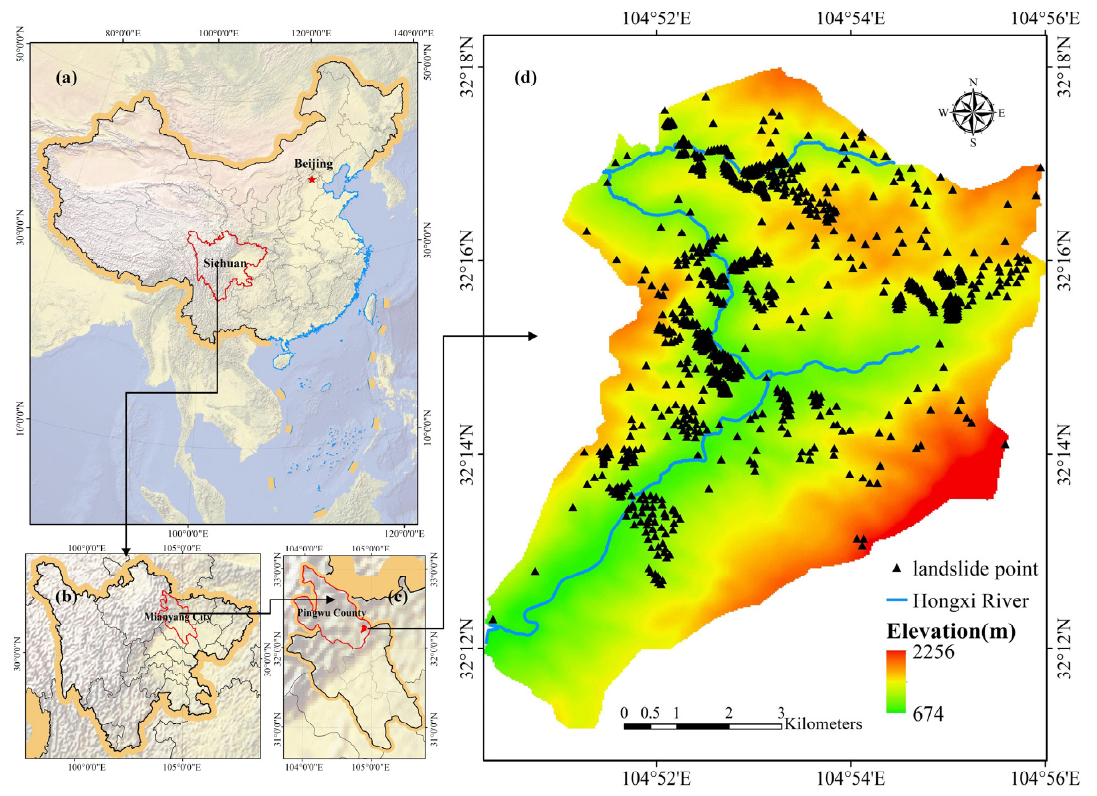
Figure 1. Study area ( a – d